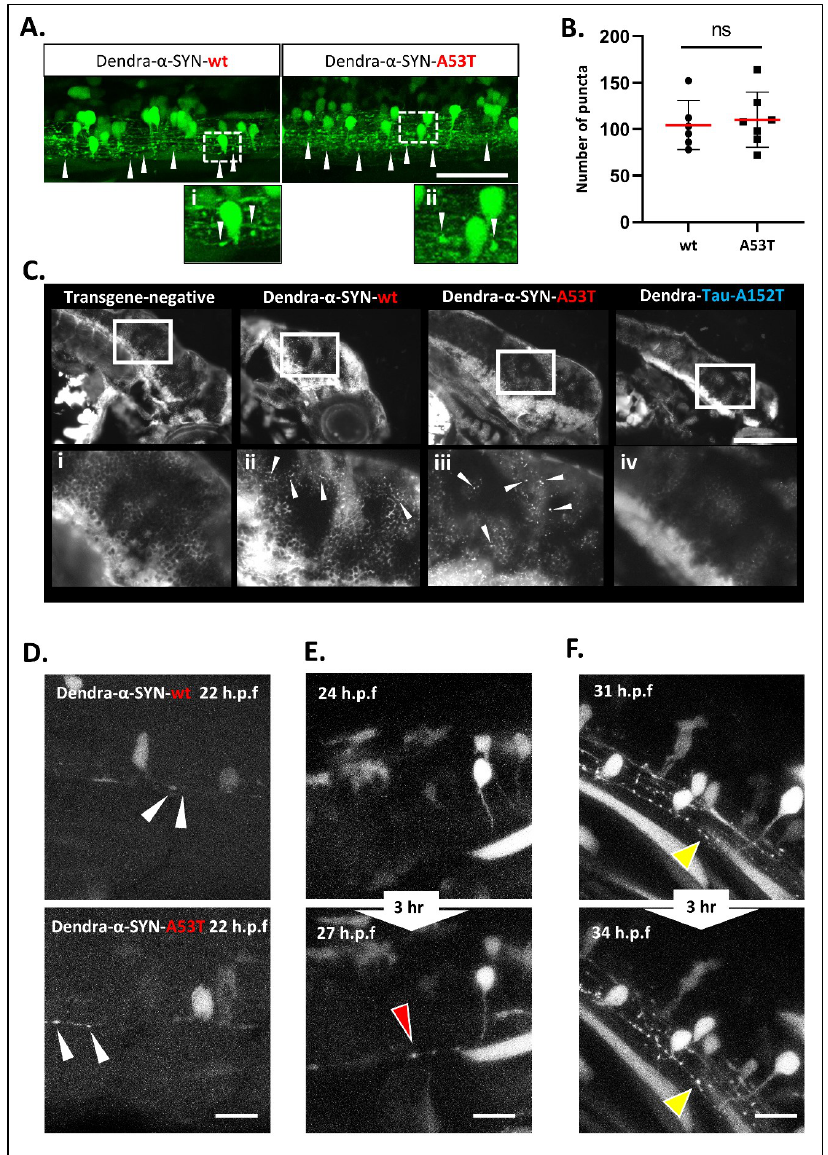
Figure 3. Accumulation and aggregation of Dendra- α -SYN. ( A ) Representative confocal images of the mosaic expression of Dendra- α -SYN in the spinal cord. Both Dendra- α -SYN-wt and A53T-expressing larvae showed bright puncta of Dendra signal along the axons (white arrowheads) in 3 d.p.f. fish. Images (i) and (ii) show puncta in axons in detail. Scale bar represents 150 µm. ( B ) Quantification of Dendra puncta seen in transverse sections across the head of 3 d.p.f larvae with pan-neuronal expression of Dendra- α -SYN-wt and A53T represented in Figure S3E. No changes were found in the number of puncta. Data represented as mean (red line) ± s.d. ( N = minimum of 6 fish, ns p > 0.05) ( C ) Thioflavin-S staining of longitudinal sections through the brain of 3 d.p.f embryos with pan-neuronal expression of Dendra- α -SYN-wt and A53T. Positive staining was observed in α -SYN -wt and A53T fish in contrast to the absence of labelling in transgene-negative siblings or Dendra-tau-A152T expressors. Panels i-iv correspond to magnified images where arrowheads point to thioflavin-s positive structures. Scale bar represents 100 µ m. ( D – F ) Representative confocal images from maximum projections of z-stacks of Dendra positive neurons in the spinal cord of mosaic Dendra- α -SYN-wt and A53T expressors at 22 h.p.f., showing the early presence of Dendra- α -SYN aggregates (white arrowheads in ( D )), de novo formation of Dendra- α -SYN-A53T aggregates (red arrowhead in ( E )), and the increase in size of aggregates within 3 h (31–34 h.p.f.) (yellow arrowheads in ( F )). Scale bar represents 25 µ